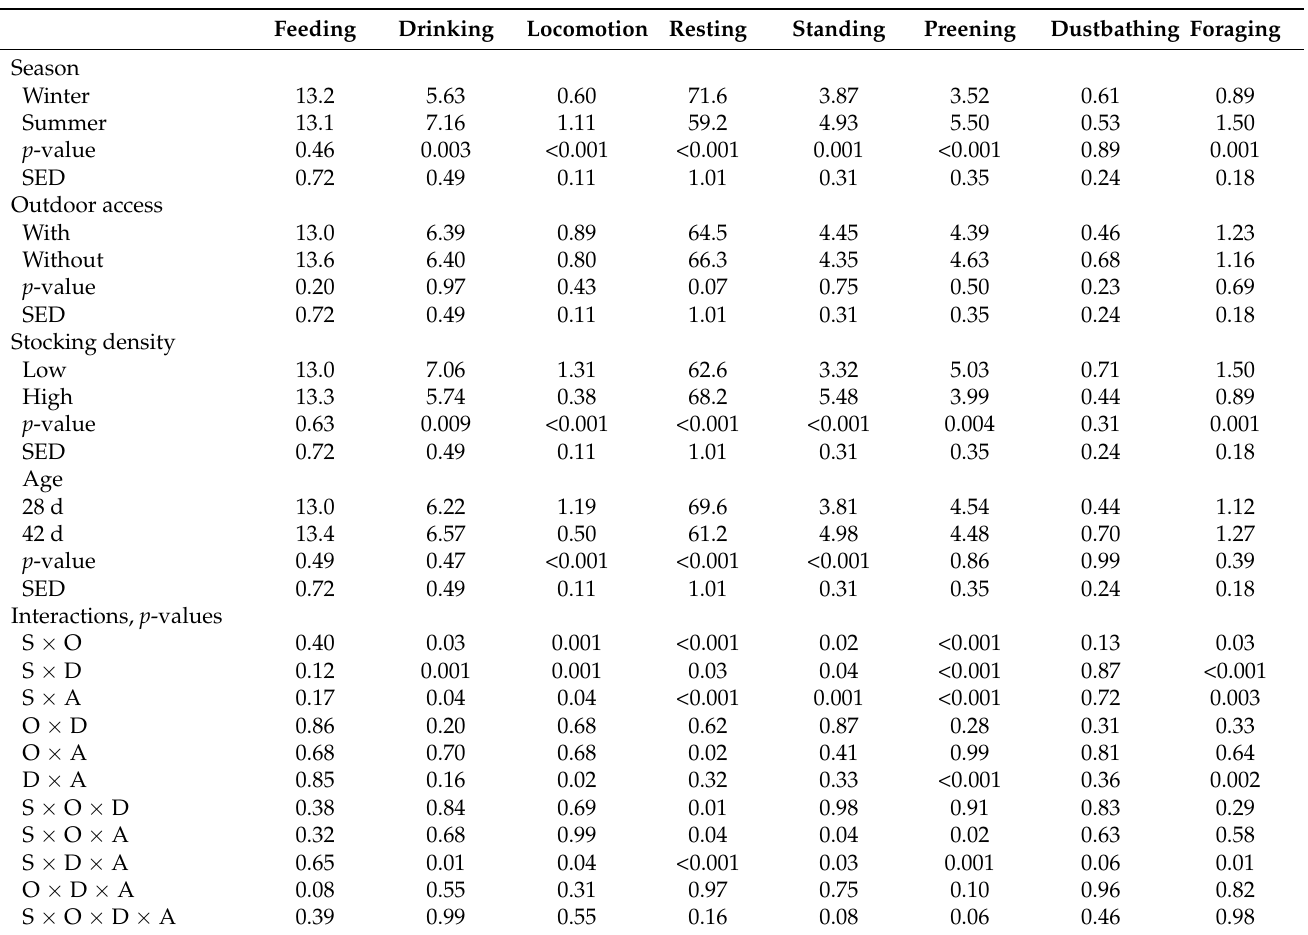
Table 3. The effects of season, outdoor access, stocking density, and age on the behavior of Cobb500 broilers 1 . Feeding Locomotion Resting Preening